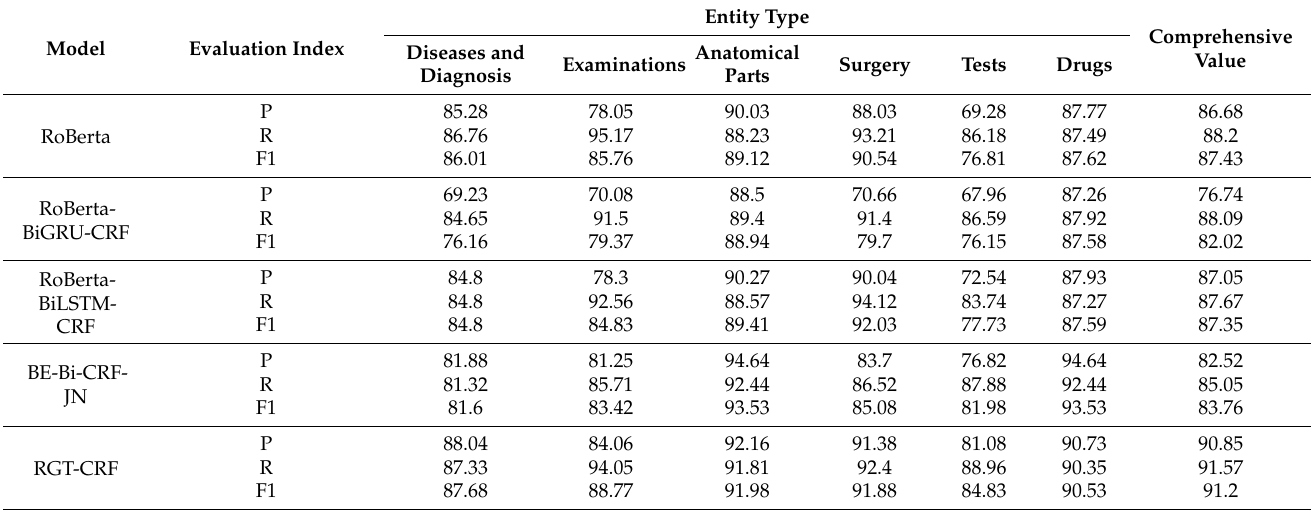
Table 5. Results of different models on